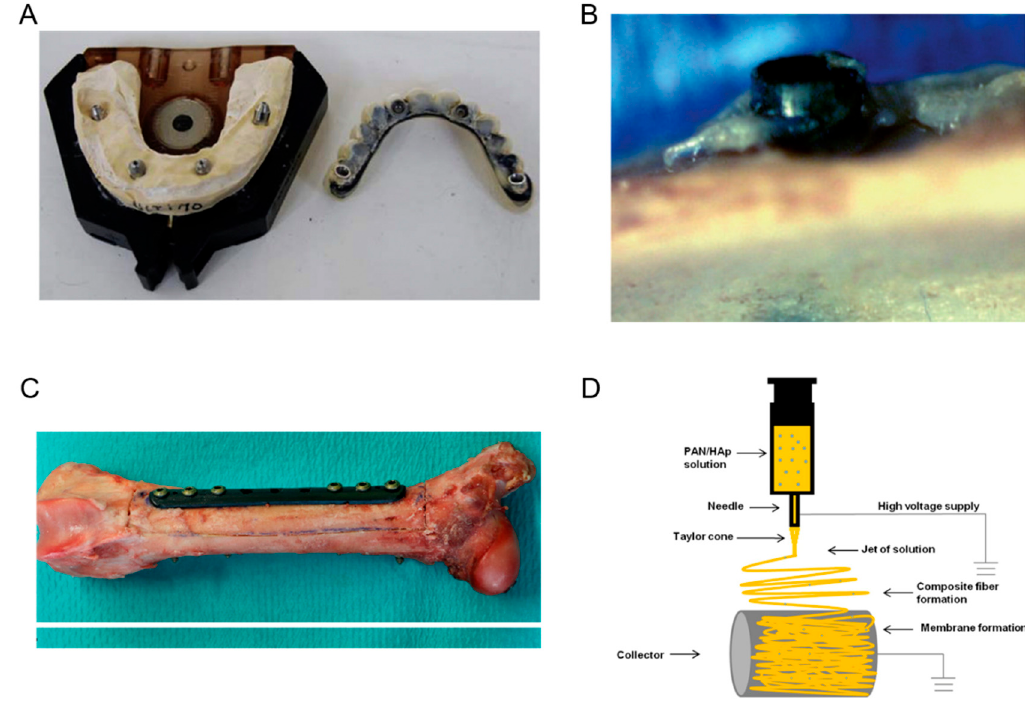
Figure 8. ( A ) Dental implant made of CF composite. Reproduced with permission from [69]. ( B ) Pictorial image of the Bisphenyl-polymer / CF implant and tissue. Reproduced with permission from [70]. ( C ) Pictorial representation of the bone prepared with the Carbon Fiber Polyether Ether Ketone (CF / PEEK) implant. Reproduced with permission from [71]. ( D ) Schematic of the electrospinning apparatus for generating CNF. Reproduced with permission from [72].